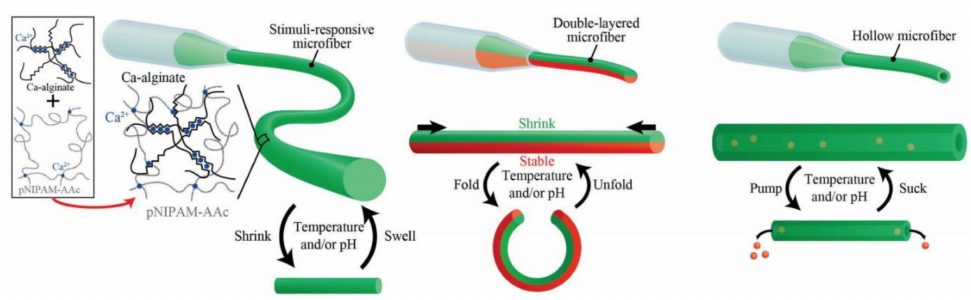
Figure 14. Schematic diagram of a pH/temperature-responsive alginate microfiber with single or double layered structure fabricated by the microfluidic